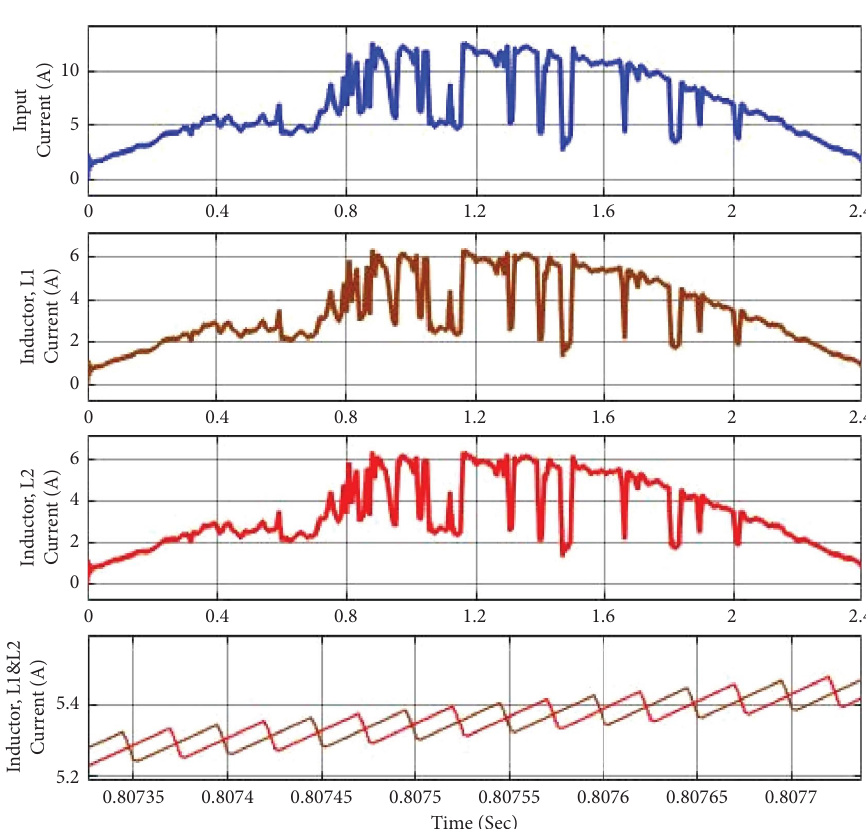
Figure 22: Current profle at input, inductor L